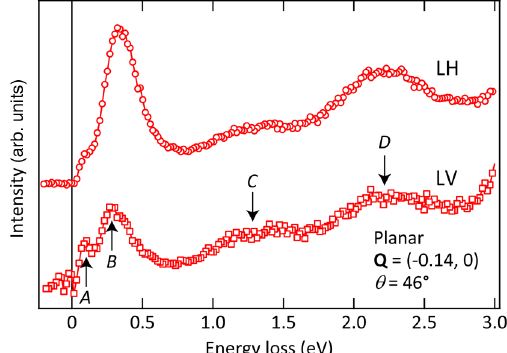
FIG. 2. Planar RIXS spectra, with elastic scattering subtracted and recorded with LH and LV light polarization for incident angle (momentum transfer) as indicated. Vertical arrows indicate the four excitations labeled A , B , C , and D . For clarity, the spectra are given an arbitrary vertical shift.